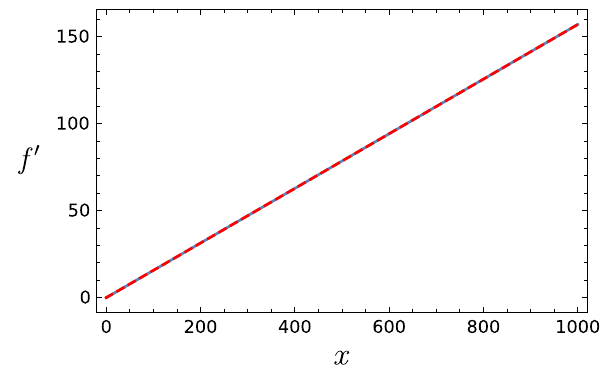
Fig. 7 CEL solution: first derivative of the potential f (cid:10) ( x ) for h 2 = as in Eq. (16). The numerical solution 10 − 4 , P = 1 / 2 and ξ 2 = ˆ λ + 2 of the full one-loop flow equation obtained from the pseudo-spectral method (solid blue line) lies exactly on top of the analytic solution in Eq. (70) for C f = 0 (red dashed